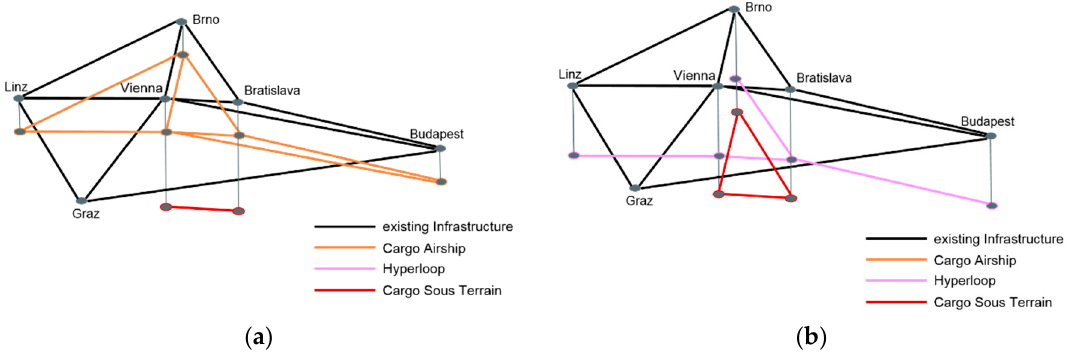
Figure 2. ( a ) Example of result for the scenario in Figure 1a; ( b ) Example result for the scenario in Figure 1b if infrastructure costs are neglected.